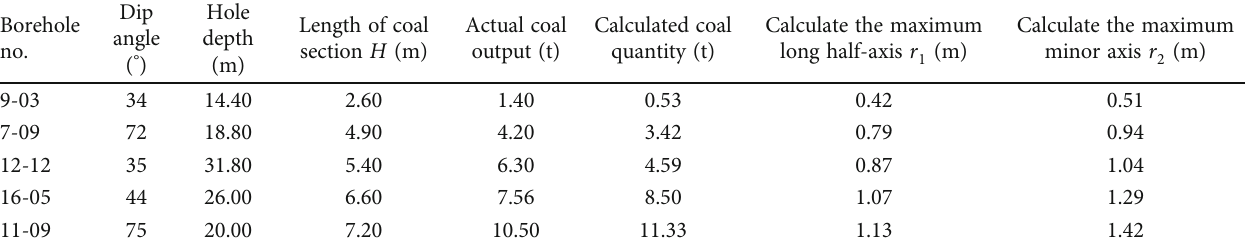
Table 1: Hydraulic fl ushing drilling parameters.